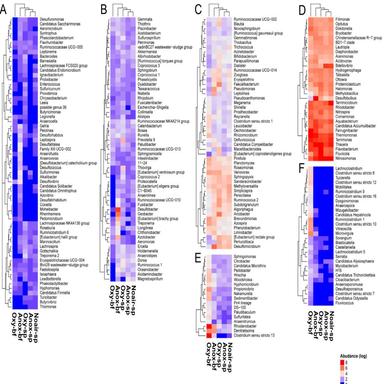
Hierarchical cluster analysis of bacterial communities. Heatmap based on log-transformed abundance values for each OTU.